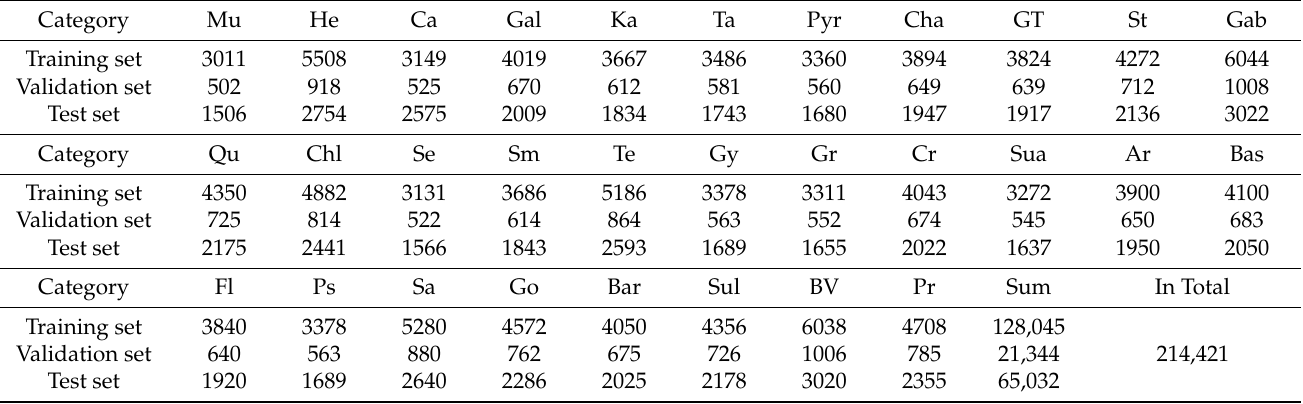
Table 2. The statistics of image patches in training set, validation set and test set. For abbreviation, muscovite (Mu), hematite (He), calcite (Ca), galena (Gal), kaolinite (Ka), talcum (Ta), pyrite (Pyr), chalcopyrite (Cha), gray tiemannite (GT), stibnite (St), gabbro (Gab), quartz (Qu), chlorite (Chl), serpentine (Se), smaltite (Sm), tennantite (Te), gypsum (Gy), graphite (Gr), crystal (Cr), suanite (Sua), aragonite (Ar), basalt (Bas), fluorite (Fl), psilomelane (Ps), saponite (Sa), goethite (Go), barite